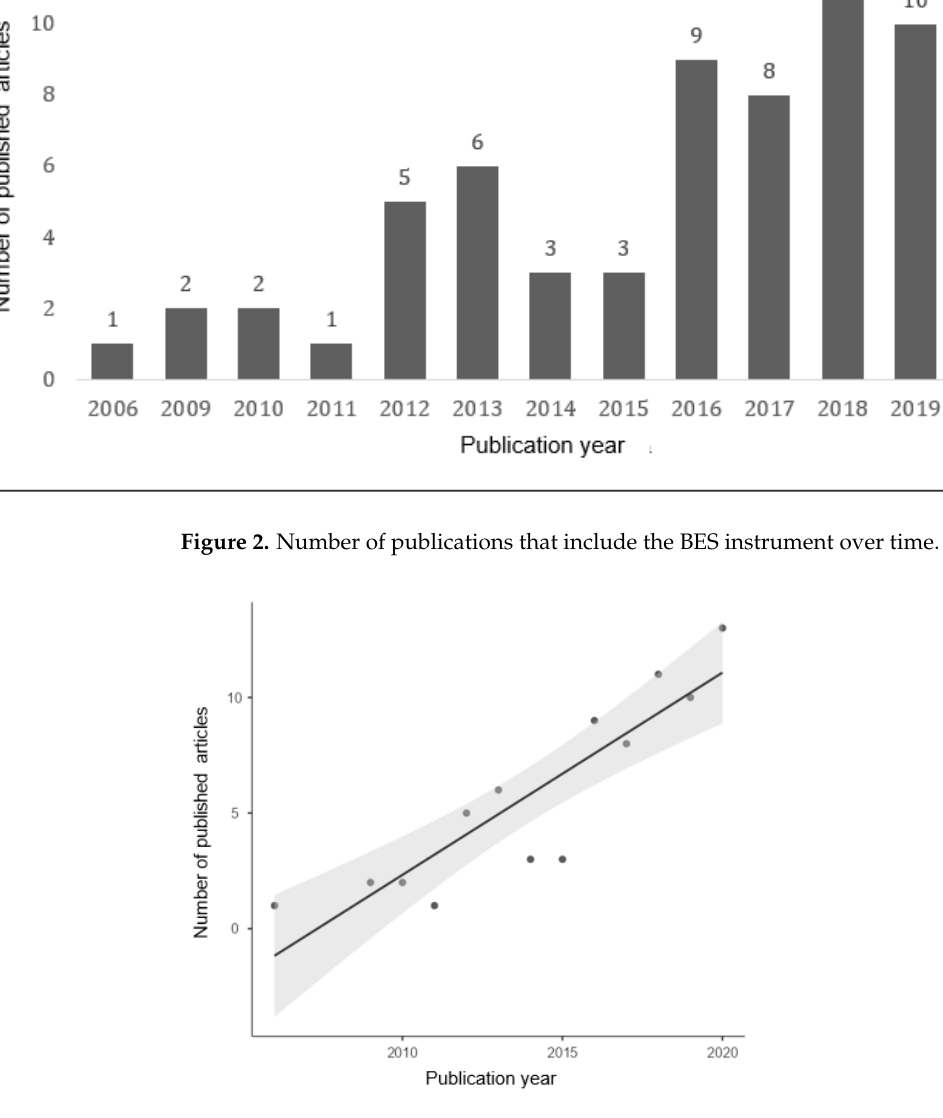
Figure 3. Scatterplot of articles published over time.